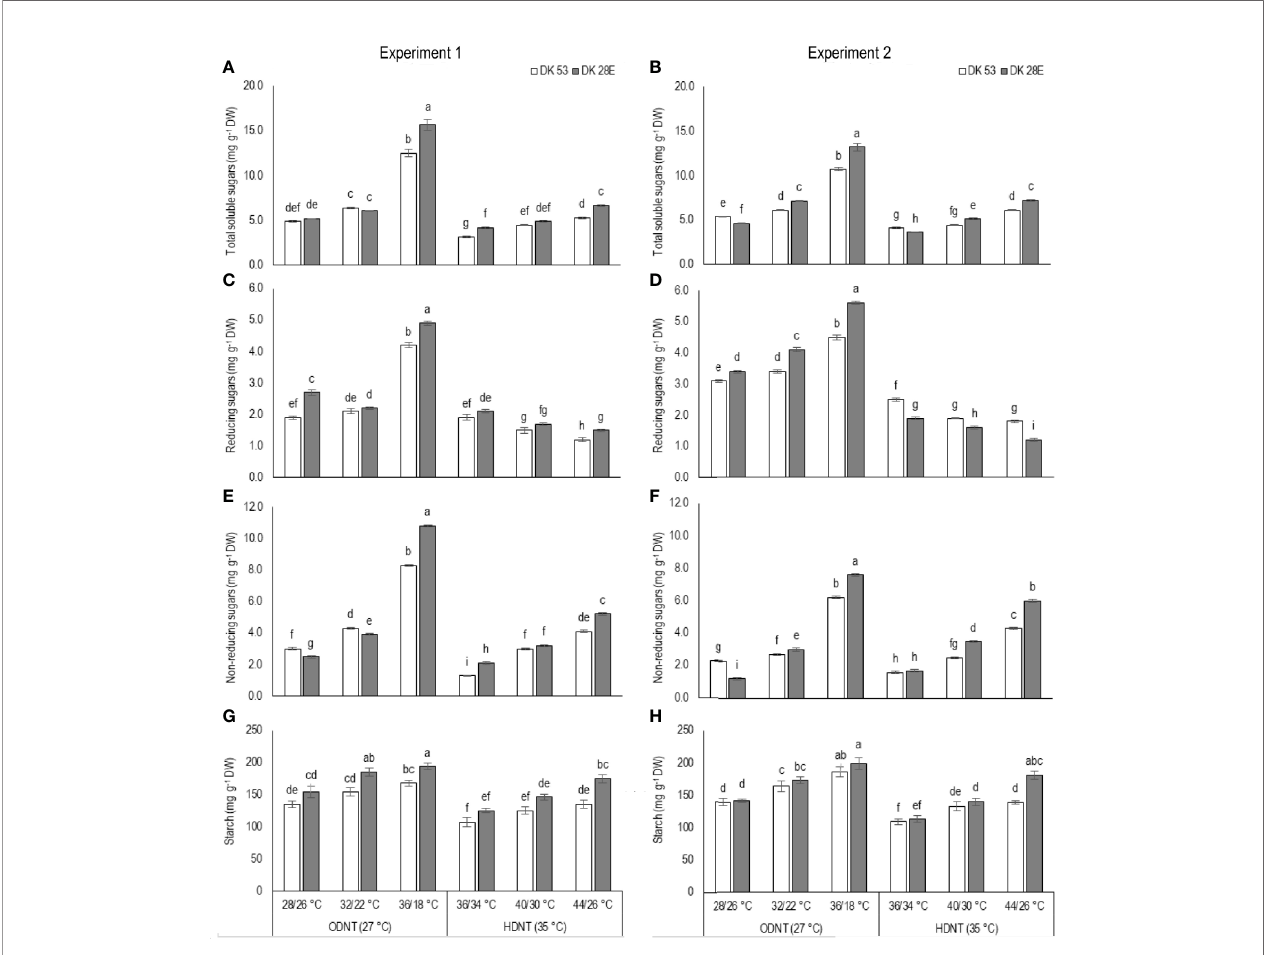
FIGURE 4 | Effect of two mean temperatures (27 and 35°C) [27°C (optimum mean daytime and nighttime temperature; ODNT) and 35°C (high mean daytime and nighttime temperature; HDNT)] with three diurnal temperature amplitudes (2, 10, and 18°C) on (A, B) total soluble sugars (TSS), (C, D) reducing sugars (RS), (E, F) non-reducing sugars (NRS) and (G, H) starch of two sorghum hybrids [DK 53 (white bar) and DK 28E (gray bar)]. Different letters in bar indicates signi fi cant difference according to Tukey ’ s HSD ( P <0.01; the test was conducted independently for each experiments). Each bar is mean value with standard error. Dry weight